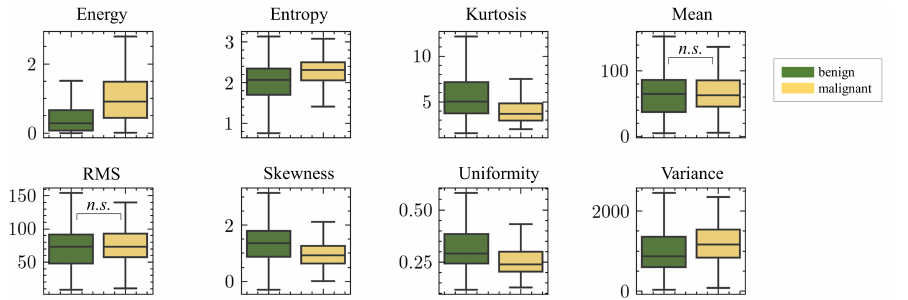
Figure 2. First-order texture features. All measured statistics, except Mean and RMS, are significantly different between the two groups of benign and malignant masses. Refer to Table A1 for a description of the metrics and t -test